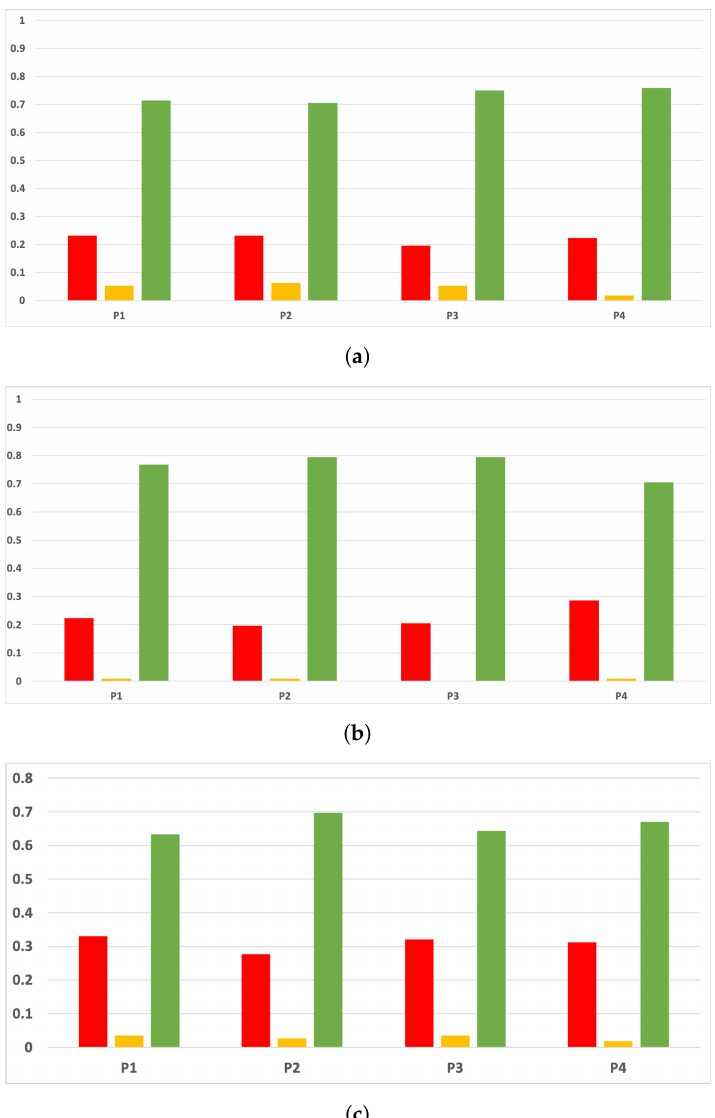
Figure 18. Experiment 1: consistency per partition (MCC and time complexity). ( a ) Rate of validity per partition in RF. In axis X, the partition of the dataset. In axis Y, the rate of RHOASo for each class of validity. ( b ) Rate of validity per partition in GB. In axis X, the partition of the dataset. In axis Y, the rate of RHOASo for each class of validity. ( c ) Rate of validity per partition in MLP. In axis X, the partition of the dataset. In axis Y, the rate of RHOASo for each class of